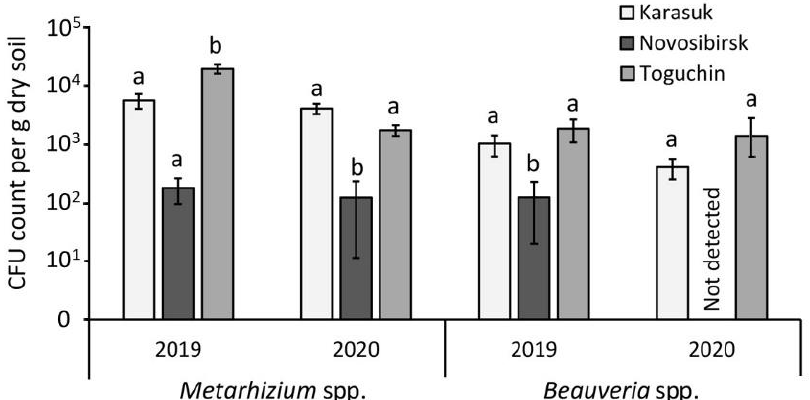
Figure 1. The CFU counts of Metarhizium and Beauveria in soil samples from plots occupied by do- mestic potato gardens (Karasuk, Toguchin) and conventional potato fields (Novosibirsk) in 2019 and 2020. Vertical lines indicate the standard errors (SE). Different letters indicate significant differences calculated for Metarhizium and Beauveria and each year separately (Dunn’s test, p < 0.05). Table 1. Endophytic colonization of potato plants with entomopathogenic fungi in different locations of Western Siberia: Karasuk (K-k), Novosibirsk (N-sk), and Toguchin (T-n). % of Fungus-Positive Plants ( n = 30 per Location) Root